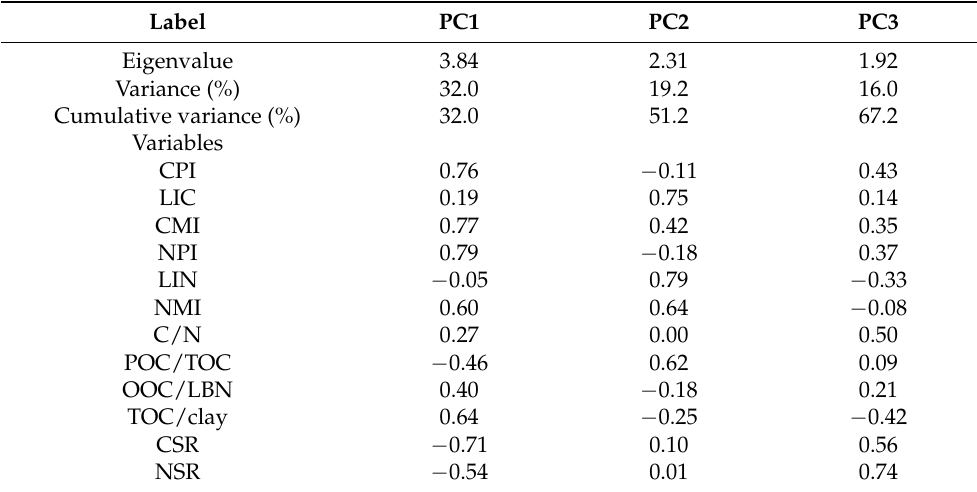
Table 9. In a hot, arid environment, principal component analysis of soil organic carbon and nitrogen indices under various land use